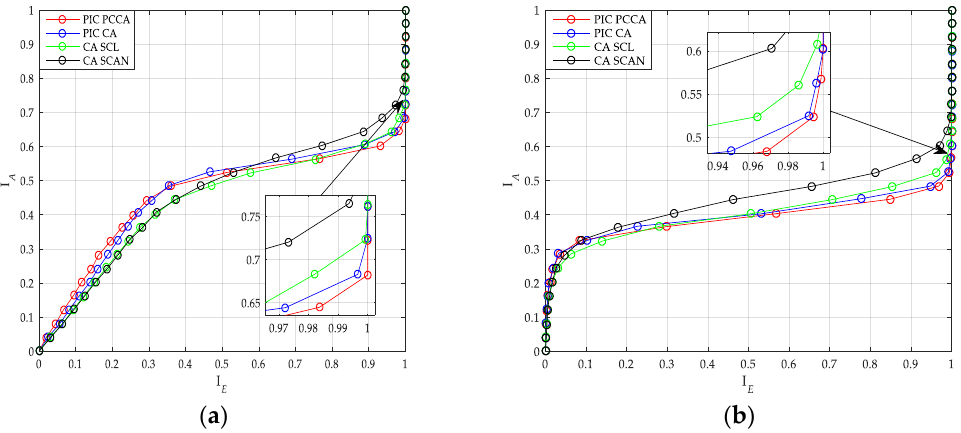
Figure 12. Transfer characteristics of polar code. ( a ) K = 100, R = 1/2; ( b ) K = 64, R = 1/3.